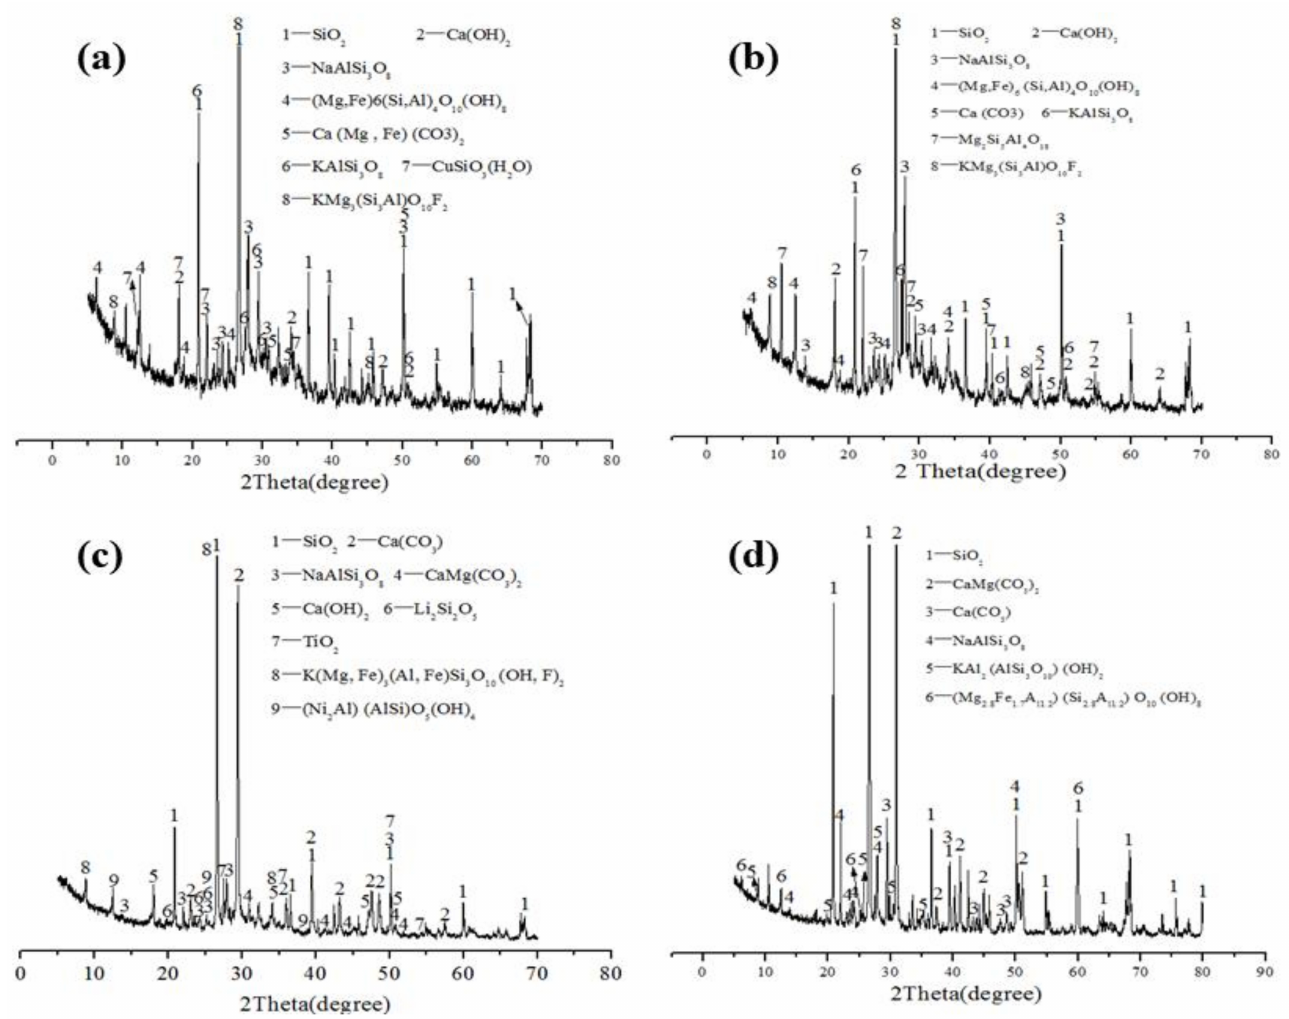
Figure 4. X-ray diffraction (XRD) patterns of the following four types of aggregates: ( a ) QH1, ( b ) QH2, ( c ) QH3, and ( d )